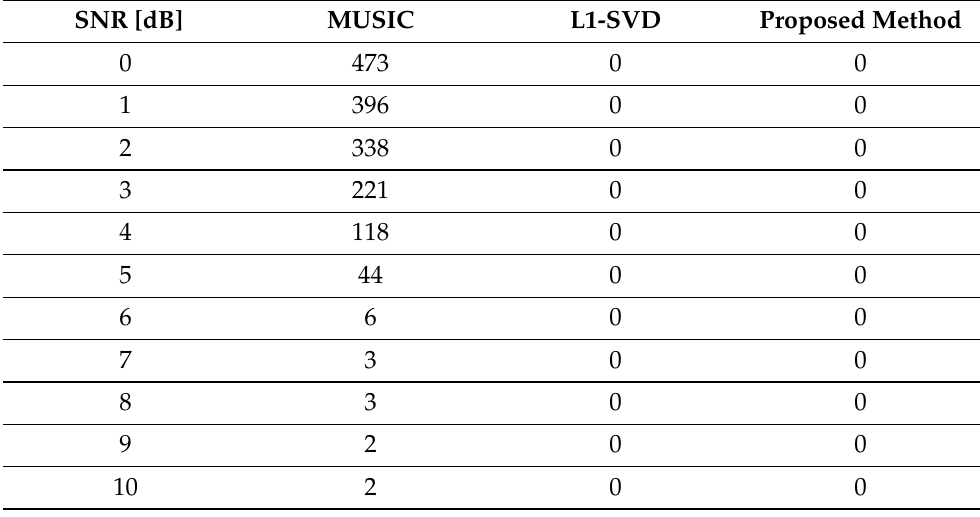
Table 3. Number of Failures in 500 Trials with Respect to SNR. Two emitters at 60 ◦ and 63 ◦ , 100